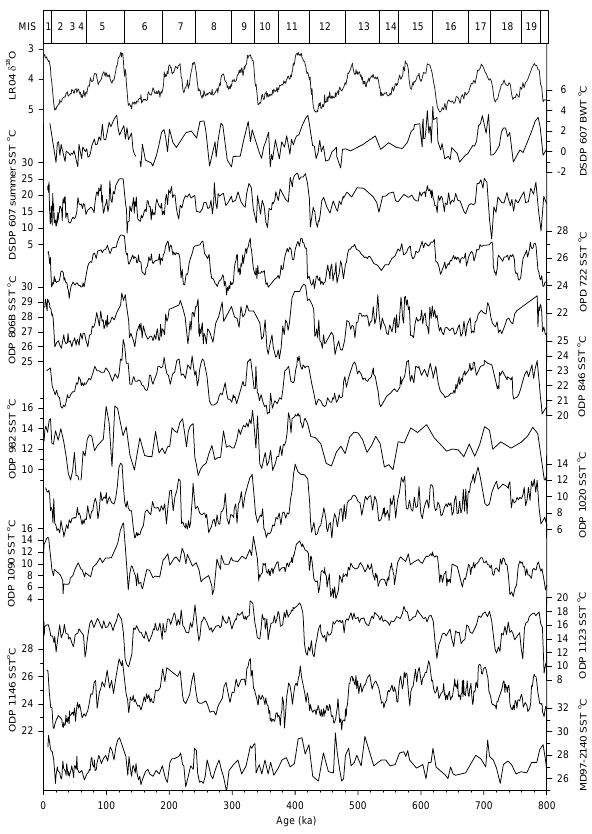
Fig. 2c. Sea surface temperature (SST) records (on individual timescales) with corresponding marine isotope stages (MIS) from LR04.